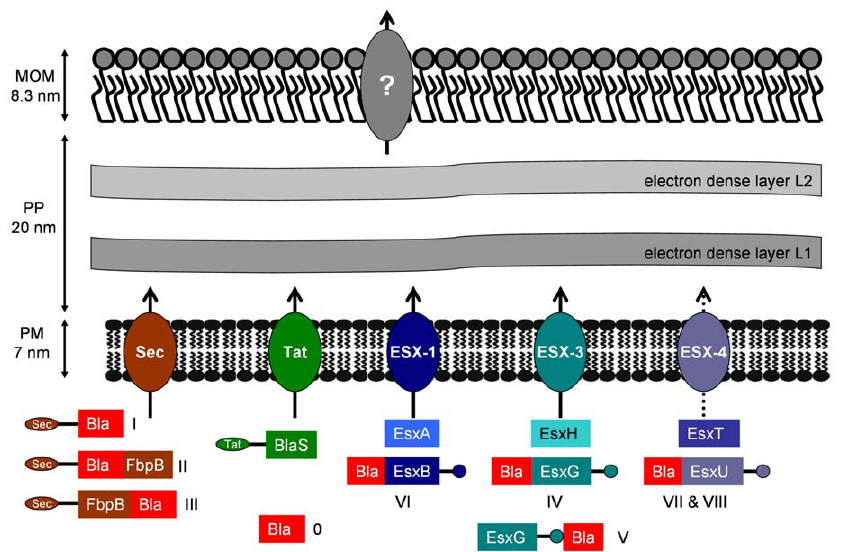
Figure 5. Schematic drawing of the cell envelope and the known protein export systems of M.smegmatis . Displayed is a simplified model of a cell envelope (without outer capsular layer) as suggested by cryo-electron tomography images [6,9]. PM stands for the phospholipid bilayer plasma membrane. The periplasmatic space (PP) contains two electron dense layers of unconfirmed identity L1 and L2. The additional membrane is the mycobacterial outer membrane (MOM). The general secretion system (Sec) is colored brown as is one of its substrate: FbpB. FbpB contains a cleavable Sec signal peptide represented as an attached oval. The twin arginine translocation pathway (Tat) is represented in green. One of its substrate is the mayor secreted b -lactamase BlaS containing a cleavable Tat signal peptide. BlaS is missing in the D blaS knock out strain. The ESX protein translocation systems 1, 3 and 4 of M. smegmatis are drawn together with their suggested heterodimeric substrates: EsxA/B, EsxH/G and EsxT/ U. EsxB, EsxG and EsxU posses a C-terminal secretion signal represented as a small attached circle. All reporter constructs used in this study are schematically represented and lettered with the corresponding roman number (cf. Fig. 1 ). The b -lactamase BlaTEM fusion partner is represented as a red box (Bla). Solid arrows indicate a functional translocation event, dotted arrow indicate that translocation function has not been demonstrated so far. The grey oval with the question mark drawn in the MOM represents a yet unknown translocation system for crossing the second permeability barrier.